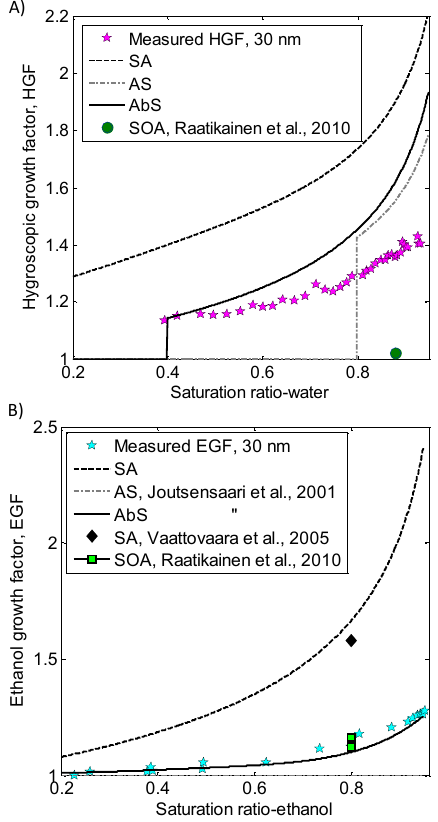
Fig. 4. Hygroscopic (A) and ethanol (B) growth factor versus satu- ration ratio for 30nm particles from pinanediol runs (Run C, in Ta- ble 1). Stars indicate values measured in this study, while lines show theoretical and measured values for pure compounds, and green squares and circles give values for an organic fraction with a simi- lar O : C ratio as obtained in this experiment (Massoli et al. (2011); Raatikainen et al. (2010) (measured for particle diameter of 50nm) and the black diamond shows the value for SA (extrapolated from 50m% H 2 SO 4 at 30nm Vaattovaara et al., 2005).